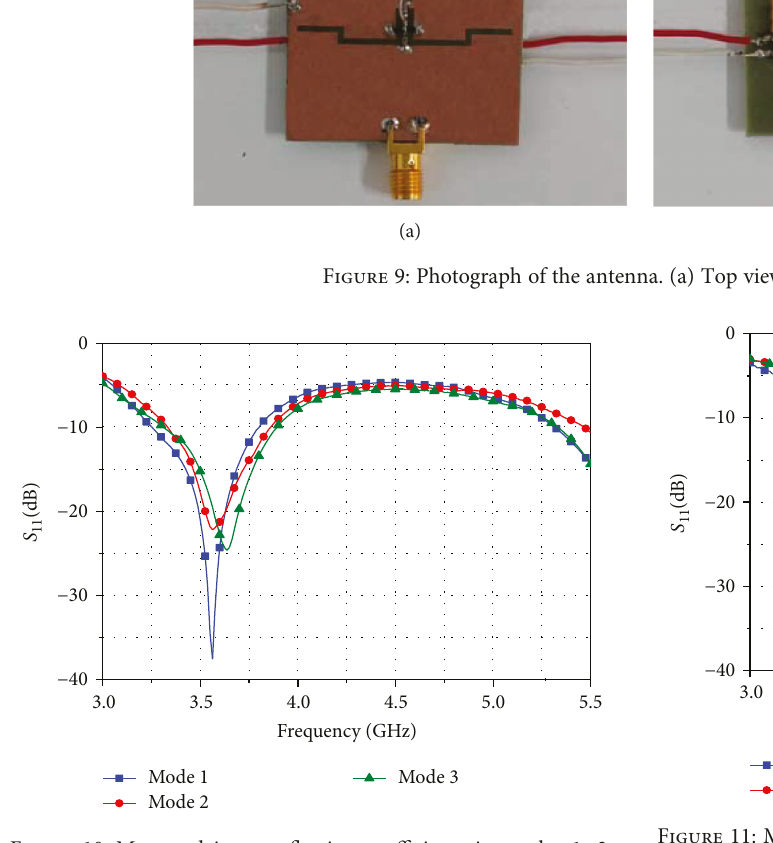
Figure 10: Measured input re fl ection coe ffi cients in modes 1, 2, and 3.